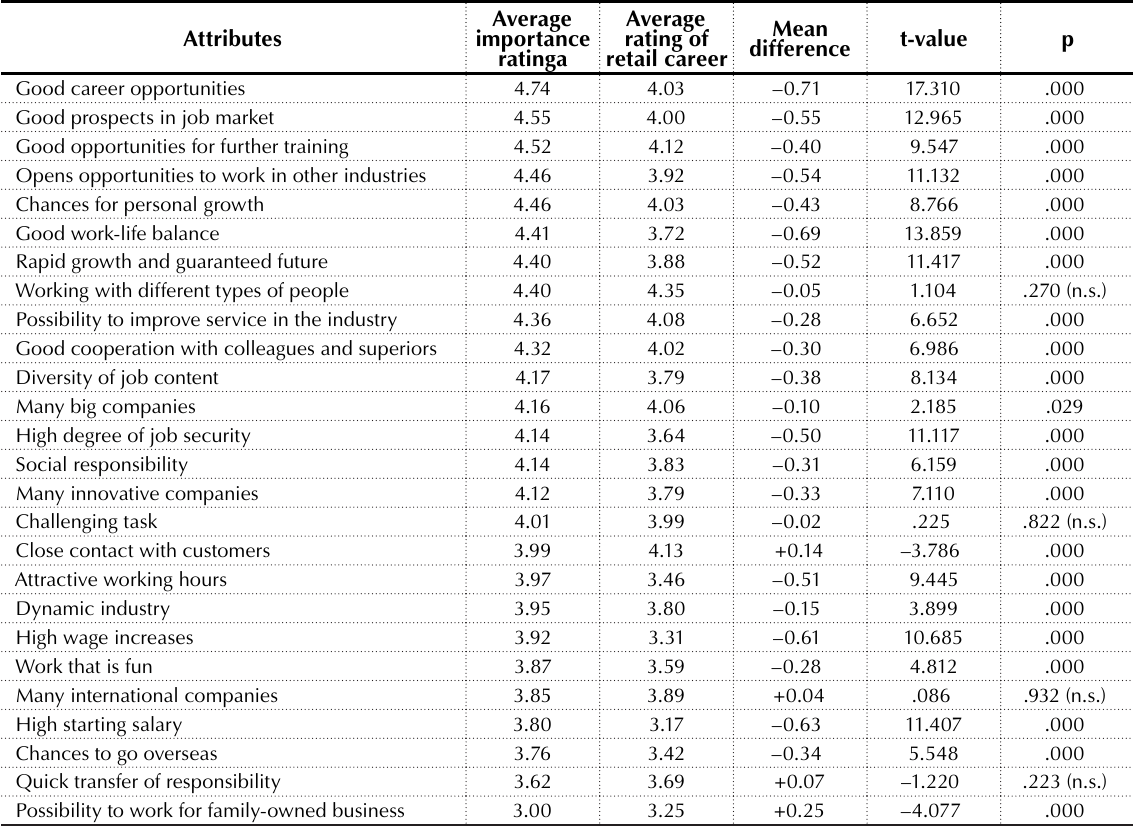
Table 8. Importance ratings and image of retail career